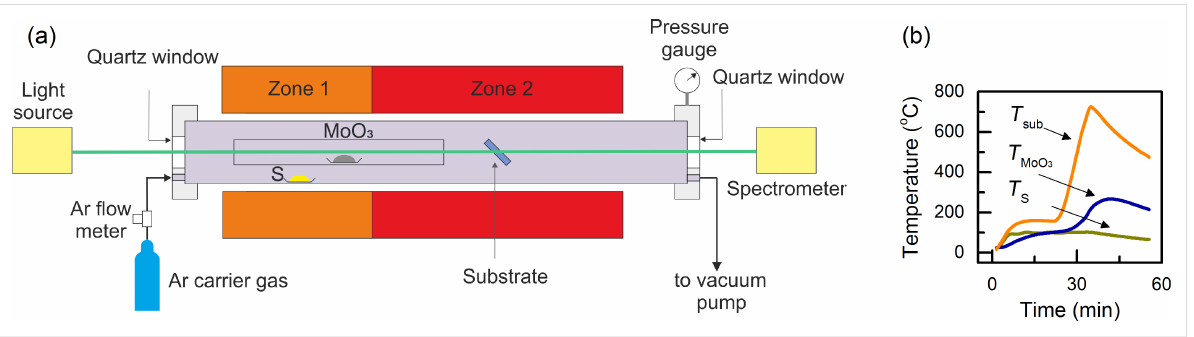
Figure 3: (a) Schematic for the CVD growth of monolayer MoS 2 . (b) Temperature profiles for the substrate, MoO 3 and sulfur.